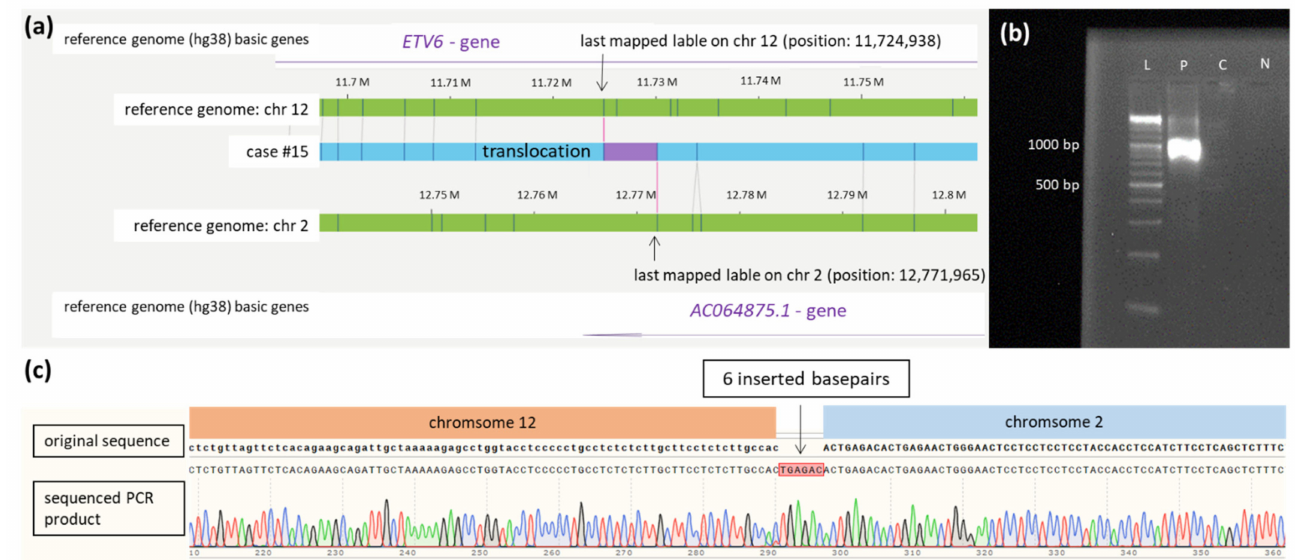
Figure 3. Translocation t(2;12). ( a ) Schematic representation of the newly identified translocation t(2,12) in case #15 detected by OGM. The first bar represents the reference genome (hg38) basic genes of chromosome 12 located at the depicted position ( ETV6 ). The second and fourth bars (green) show the reference genome map of chromosome 2 and chromosome 12. The third bar (blue) represents the map of case #15. The fifth bar represents the reference genome (hg38) basic genes of chromosome 2 located at the depicted position ( AC064875.1 ). Vertical blue lines represent mapped labels. ( b ) Validation of the translocation t(2;12) in case #15 via PCR showing a product of 1138 bp spanning translocation t(2,12) (ranging from 12,767,669 on chromosome 2 to 11,725,810 on chromosome 12). The healthy control-DNA and the negative control were both negative in the PCR. ( c ) Sequenced PCR product spanning the breakpoint of translocation t(2;12) in case #15 with insertion of 6 base pairs. In the first row, the original sequence of chromosome 12 followed by chromosome 2 is shown (modified from the figure as shown in the SnapGene program TM ). The second row depicts the electropherogram and sequence of PCR product of case #15 aligned to the original sequences spanning the breakpoint of the translocation. Insertion of 6 base pairs (marked red) at the breakpoint is shown in the middle of the second row and probably results from DNA repair mechanisms at the breakpoint. Abbreviations: C = control-DNA; chr = chromosome; hg38 = human genome project 38; ETV = ETS variant transcription factor 6; L = length marker; N = negative control (H 2 O); P = sample from case #9 collected at